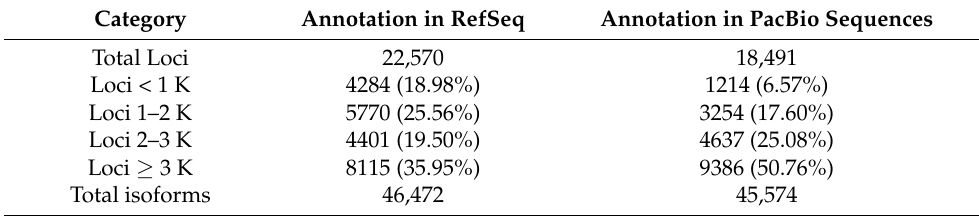
Table 4. The loci and isoform annotation of the goat RefSeq and PacBio